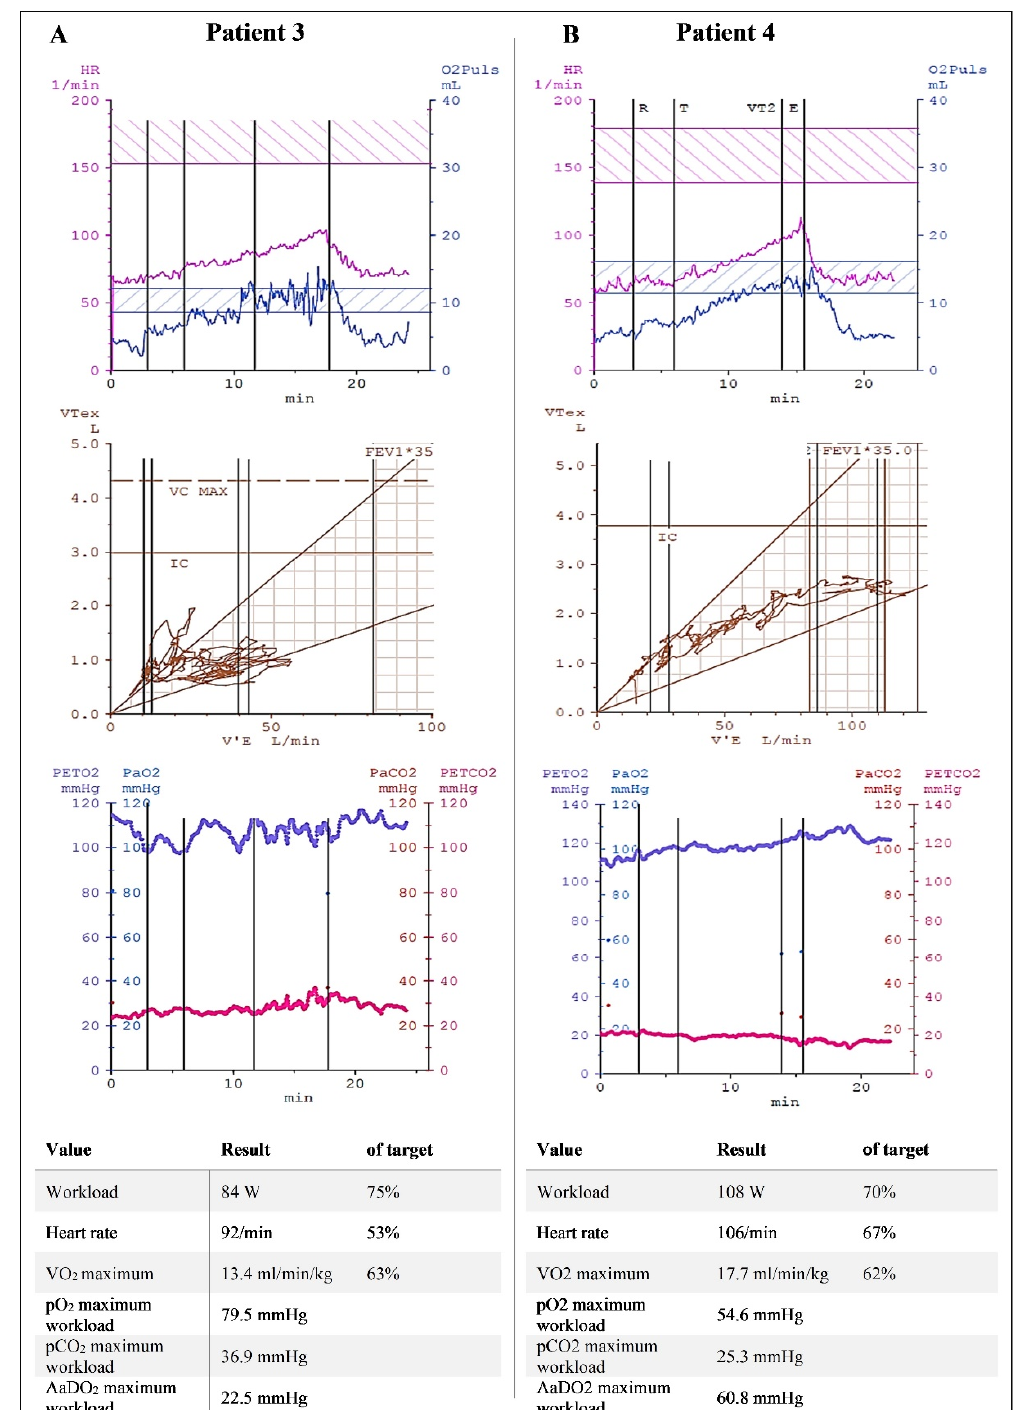
Figure 3. Cardiopulmonary exercise testing of a patient with dysfunctional/chaotic breathing ( A ) and a patient with pulmonary–vascular limitation ( B ). The patient with dysfunctional breathing was characterized by erratic and abrupt changes in respiratory rate (middle), with subsequent increased dead space and early termination at only 75% of the predicted workload. The patient with pulmonary–vascular limitation had normal ventilatory volumes (middle) with low expiratory carbon dioxide (red line, bottom panel). The alveolar-to-arterial oxygen partial pressure difference was extremely high (60.8 mmHg). (FEV1*35 is the product of one second capacity and 35 to estimate the maximum voluntary